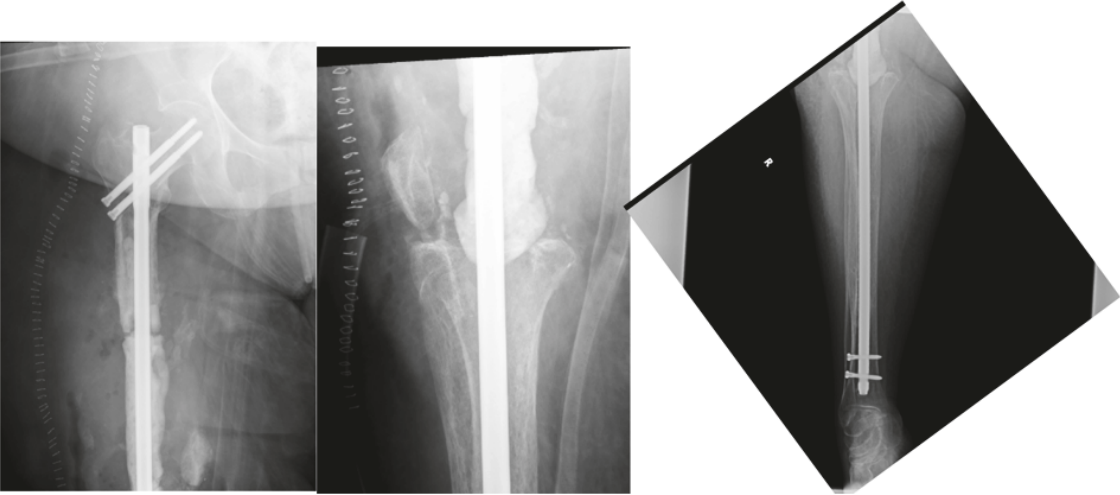
Figure 10: Postoperative radiographs showing long IM nail and surrounding bone